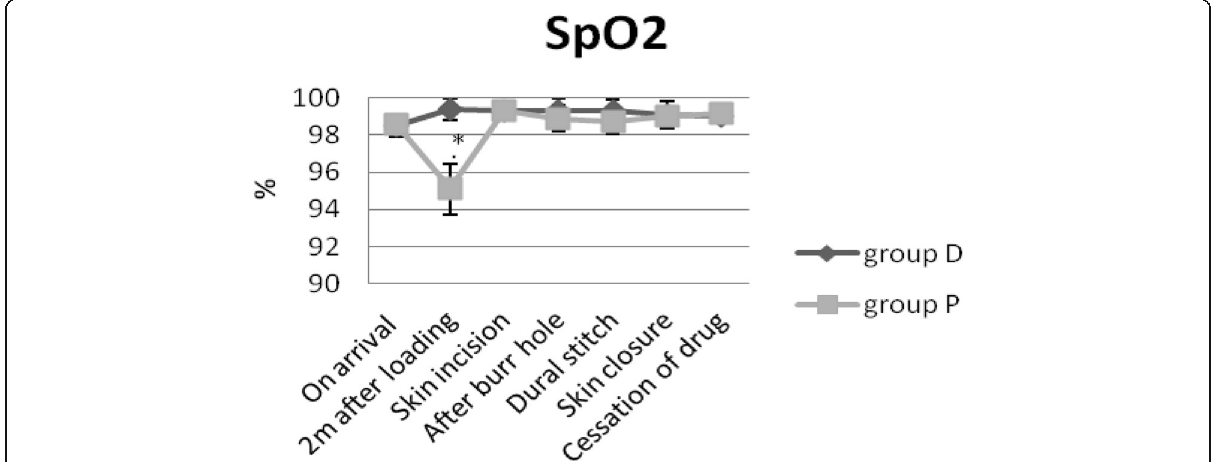
Fig. 5 Changes SpO 2 . Changes in mean values of SpO 2 over time. Lines are mean SpO 2 and error bars are SD. *Statistical significance between groups